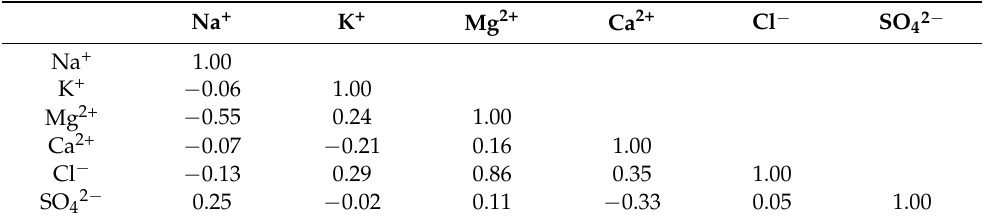
Table 1. Correlations coefficient of ionic concentrations of all brine samples.